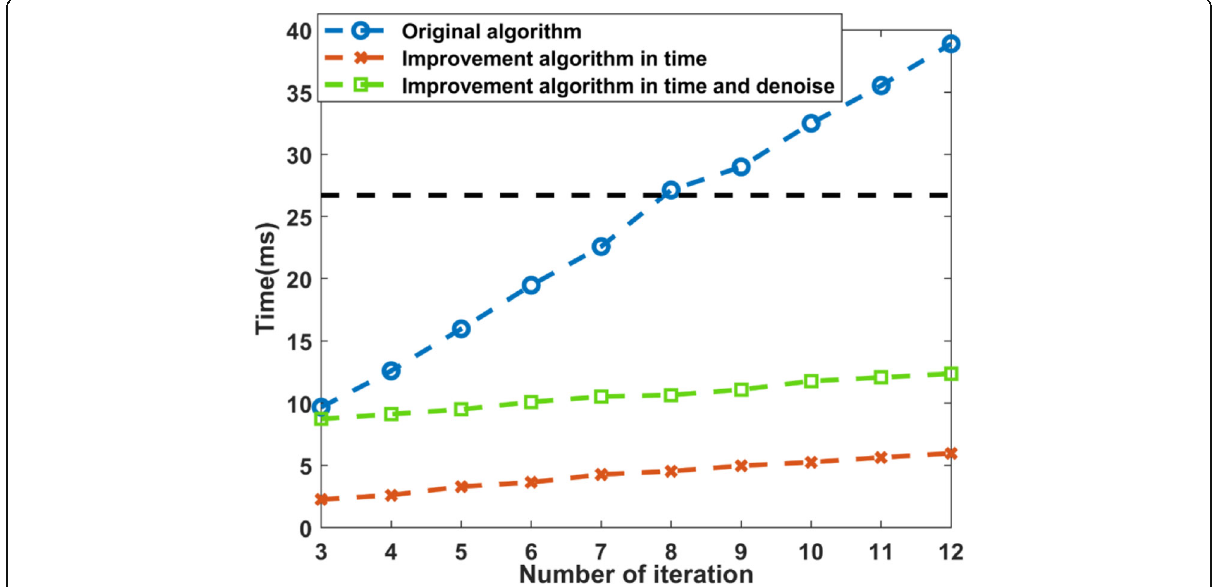
Fig. 4 Time performances of three algorithms: the time performances of the original algorithm (represented by the blue dashed line), the processing time-improved algorithm (represented by the red dashed line), and the processing time and noise resistance-improved algorithm (represented by the green dashed line). The x -axis is the number of iterations and the y -axis denotes the time in